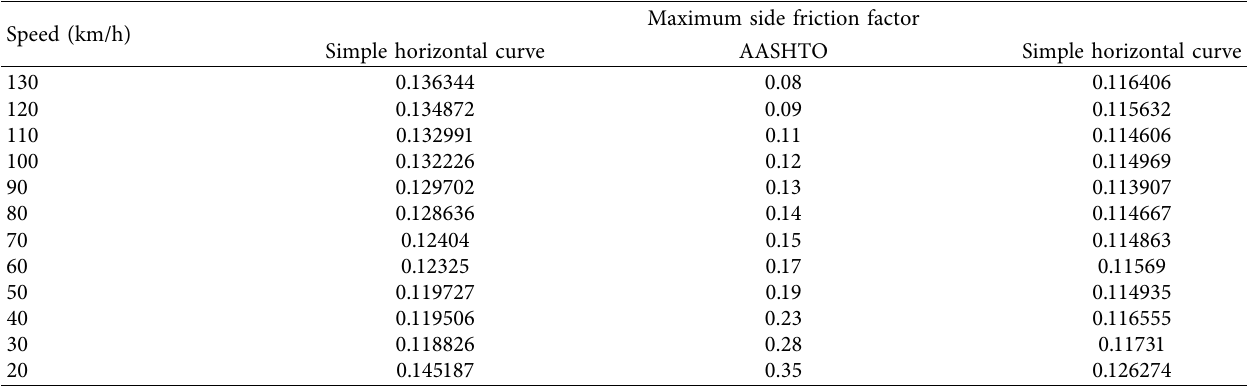
Table 21: Comparison of the maximum side friction factor for SUV between simple and spiral horizontal curves and AASHTO rec- ommended values at a radius of 0.7